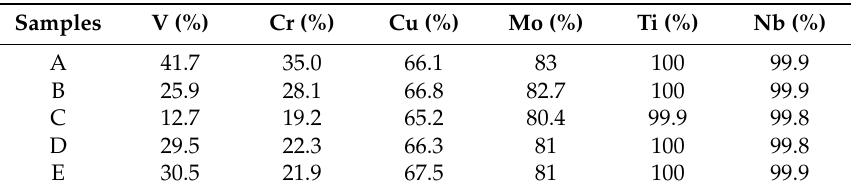
Figure 3. Engineering stress-strain curves. Table 3. Effects of the hot-induction bending and tempering on the percentage of the alloying elements that precipitated.